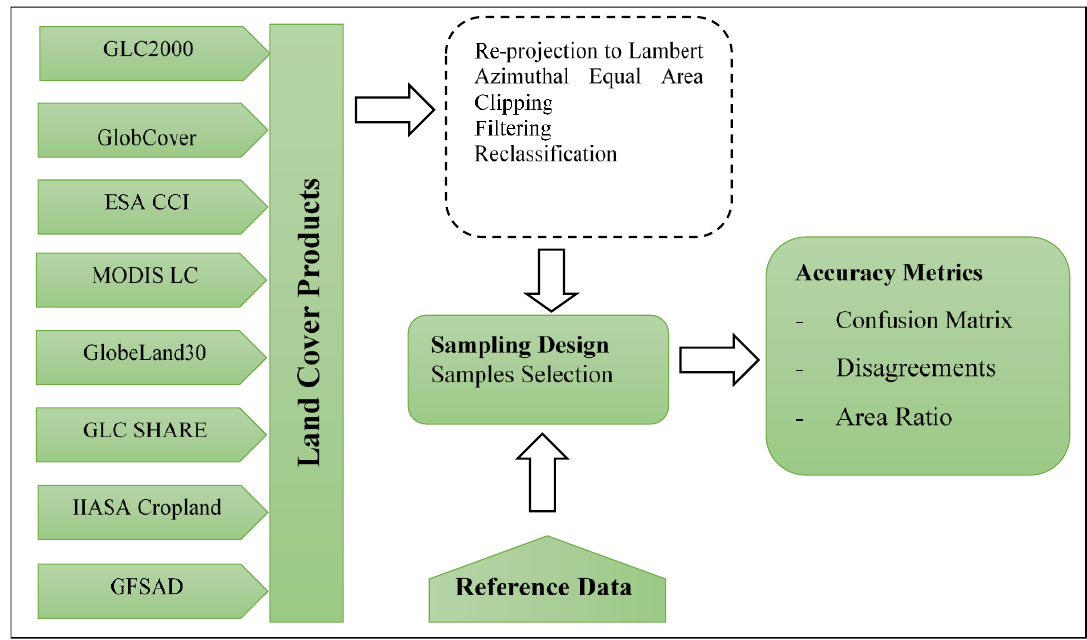
Figure 1 . Major steps of the accuracy assessment of different land cover products. Figure 1. Major steps of the accuracy assessment of different land cover